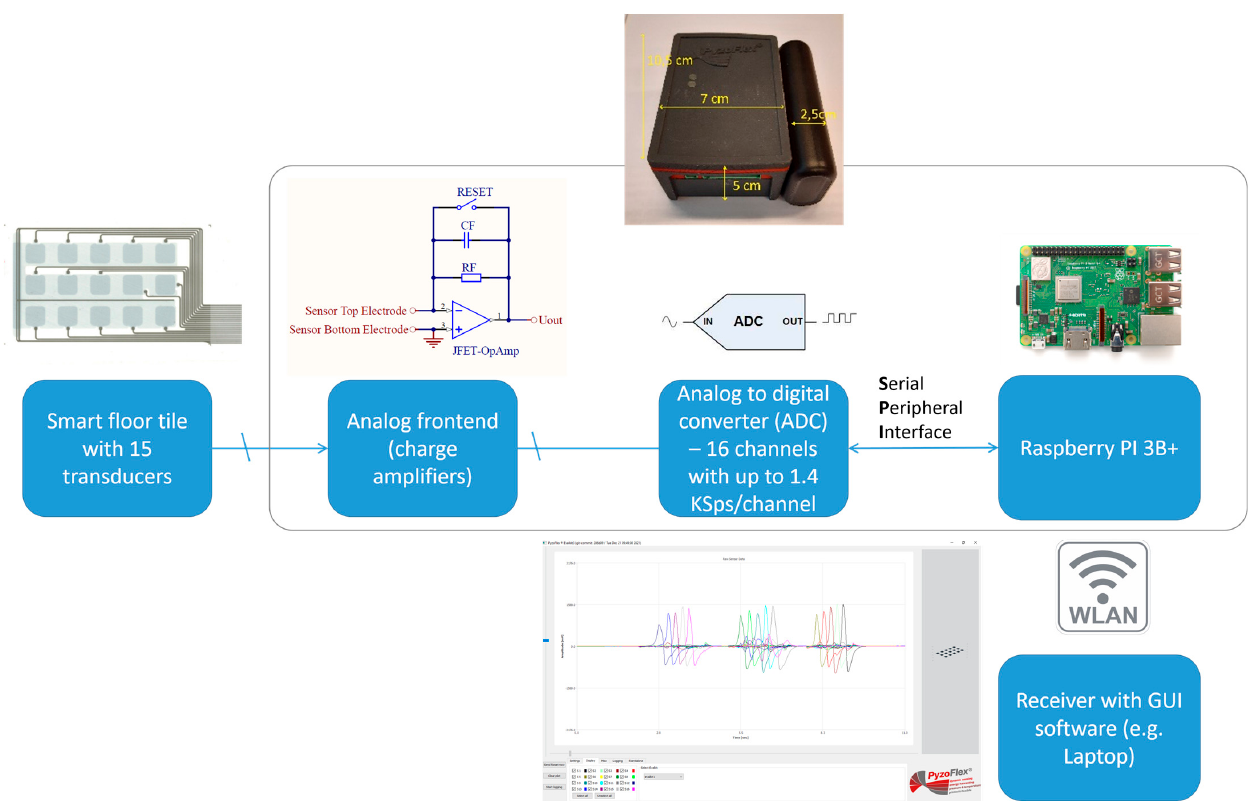
Figure 9. Demonstration setup, consisting of: ( A ) battery, ( B ) 16-channel wireless data acquisition